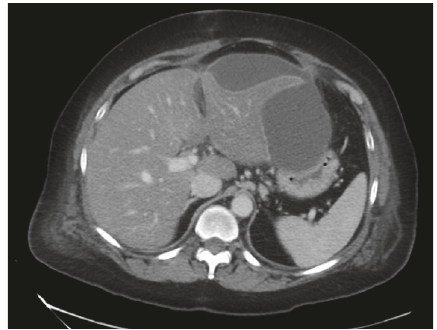
Figure 1: Preoperative ultrasound shows cholelithiasis.